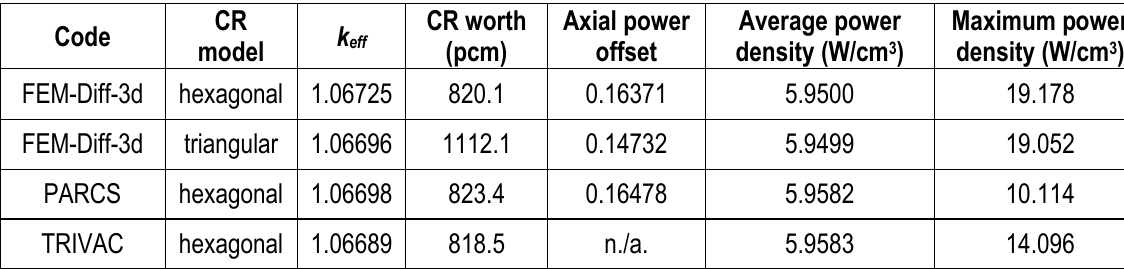
Table 1. Results obtained for global